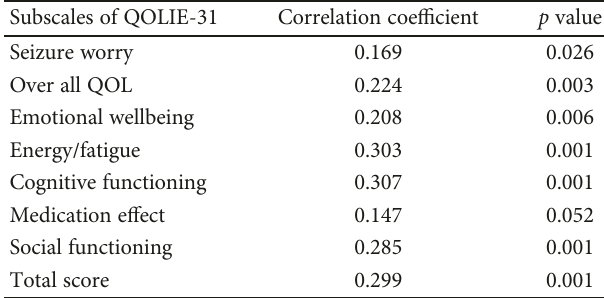
Table 5: Correlation between level of education and total score of QOLIE-31 subscale in ACSH and Mekelle